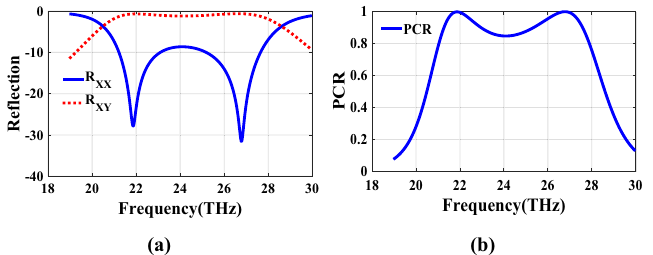
Figure 22. ( a ) Reflection coefficients of co and cross polarized reflected waves of the fourth structure, ( b ) PCR of the fourth structure.